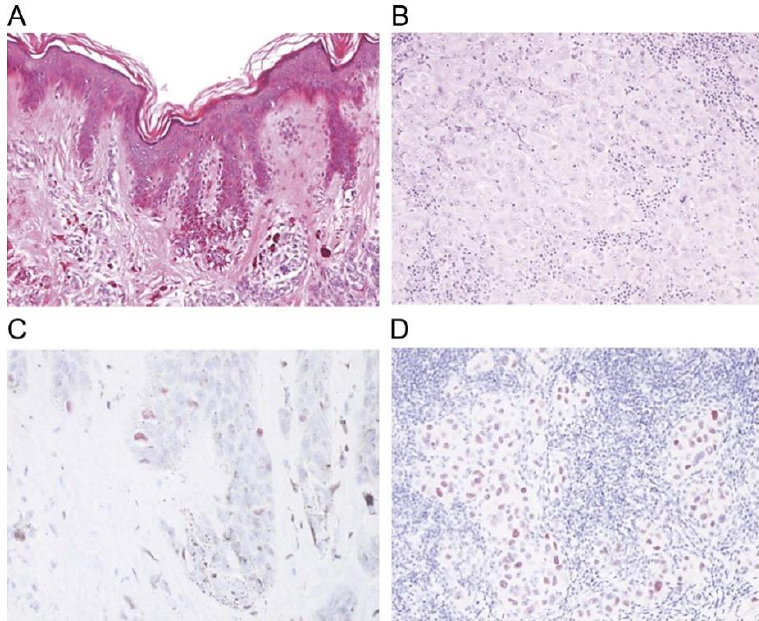
Figure 11. Immunohistochemical stain for PRAME (preferential expressed antigen in melanoma ): (Reproduced from “Metastatic PRAME Expressing Juvenile Spitzoid Melanoma on the Buttock” by Muto et al., published by Karger Publishers under the Creative Commons CC-BY-NC 4.0 license, © The Author(s) [133] . ( A ) Histology of primary lesion, ( B ) Histologic findings of a metastatic lymph node, ( C ) PRAME immunohistochemical staining of the primary tumor ( D ) PRAME immunohistochemical staining of a metastatic lymph node [133] .